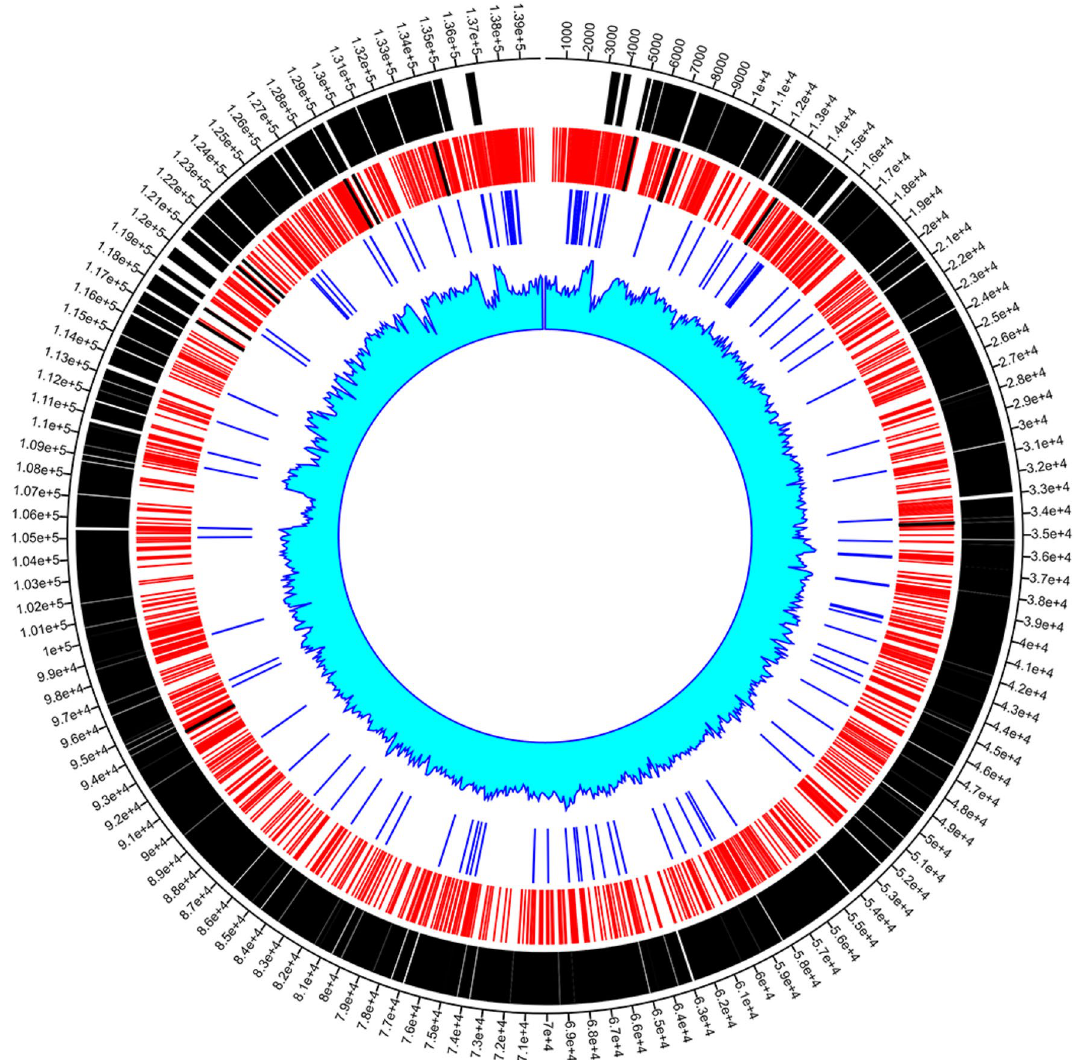
Figure 4. Circos plot showing the Genome size, CDS, Distribution of SSRs, selected SSR markers, cSSRs and GC content in ORFV (OV-SA00) genome. From outer track to inner track: Genome size, CDS, SSRs, selected SSR markers (Black lines within the SSR), cSSRs and GC